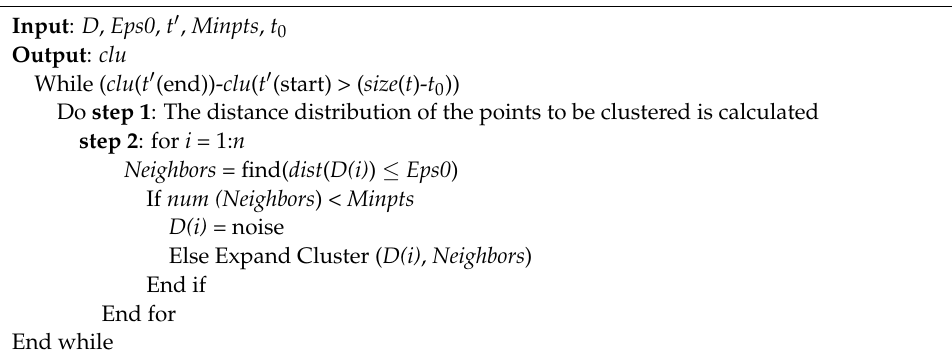
Algorithm 1 : Spatiotemporal Cluster Algorithm